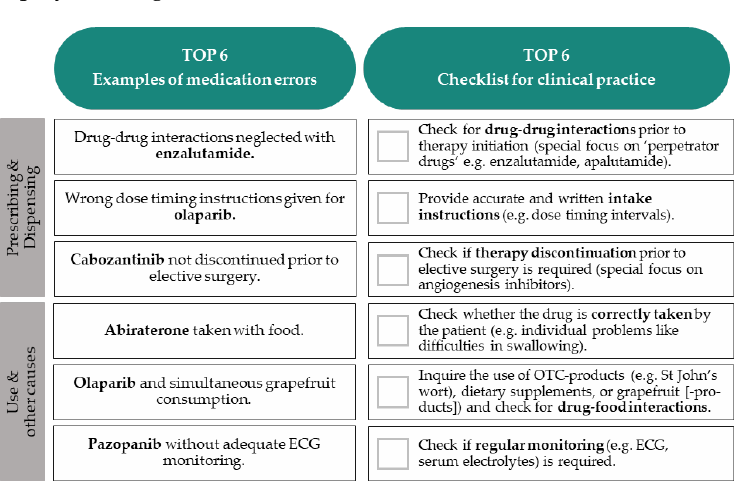
Figure 4. Top six medication errors in patients with PC or RCC treated with new oral antitumor drugs within the first 12 weeks of therapy and checklist for clinical practice. Abbreviations: ECG = electrocardiogram.